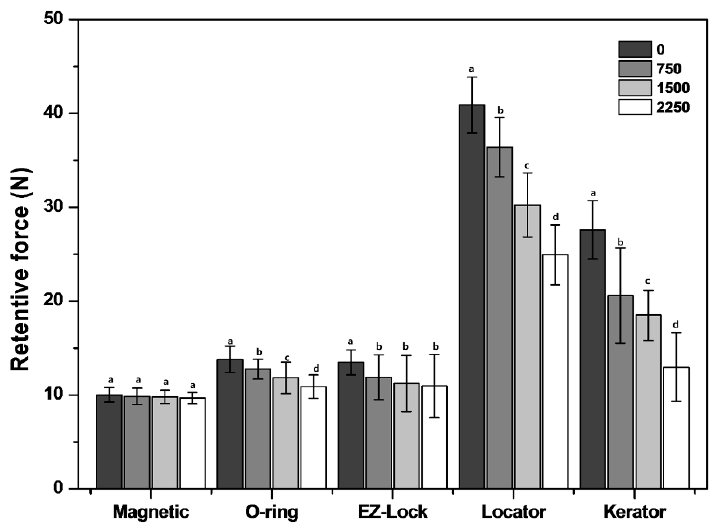
Figure 3. Changes in retentive forces observed in the insertion–removal cyclic test. Di ff erent letters above the bars indicate significant di ff erences ( p < 0.05) Error bars represent ± standard deviation of the